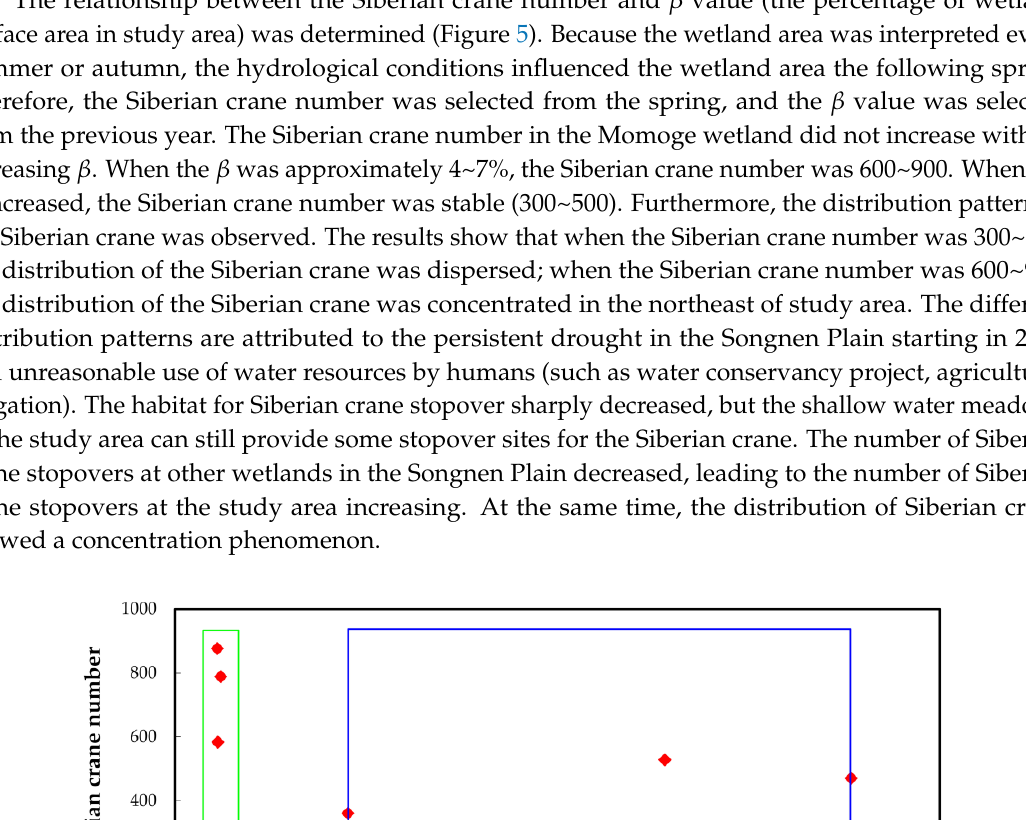
Figure 4. Variation of wetland area in study area.